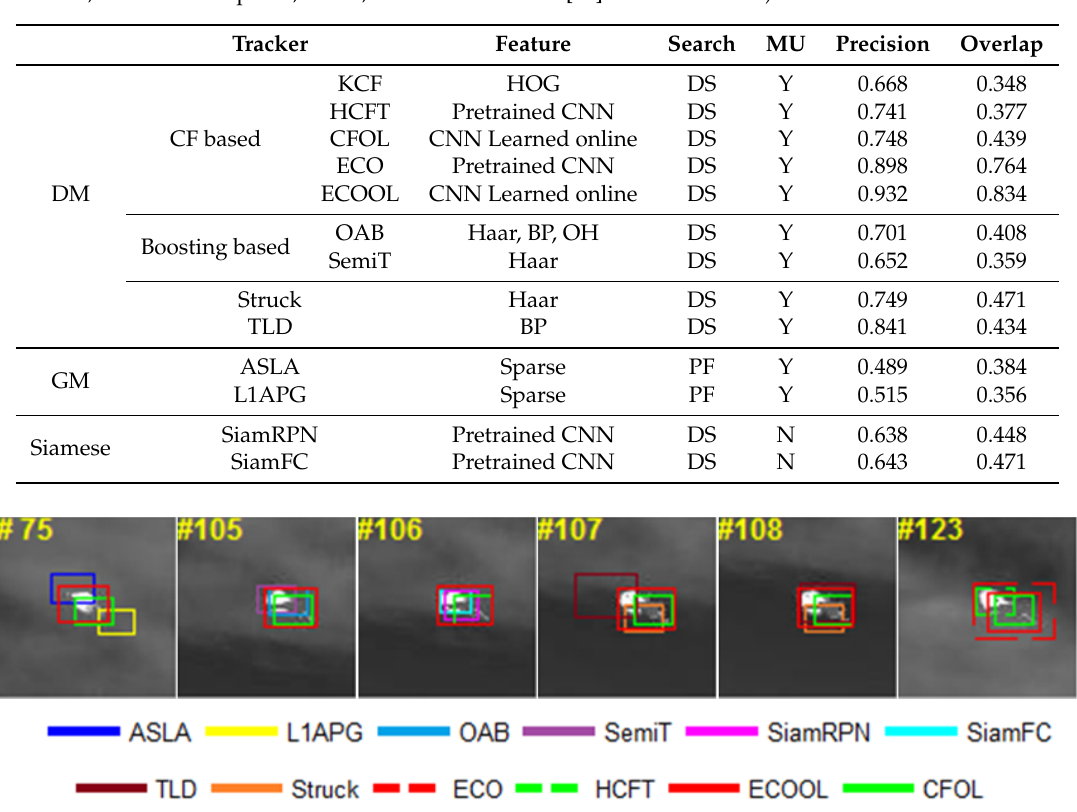
Table 3. Evaluation of the tracking results. (DM: Discriminative Model, GM: Generative Model,